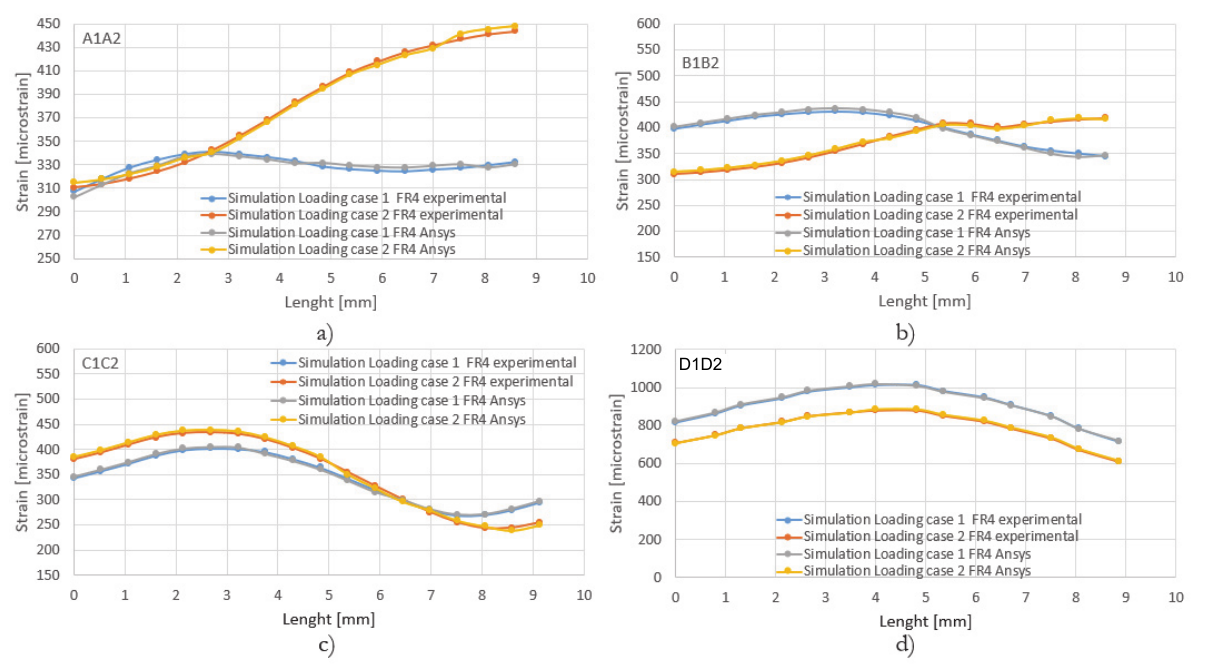
Figure 8: Maximum principal strain distribution on PCB (FEA results): a) A1-A2; b) B1-B2; c) C1-C2; d)